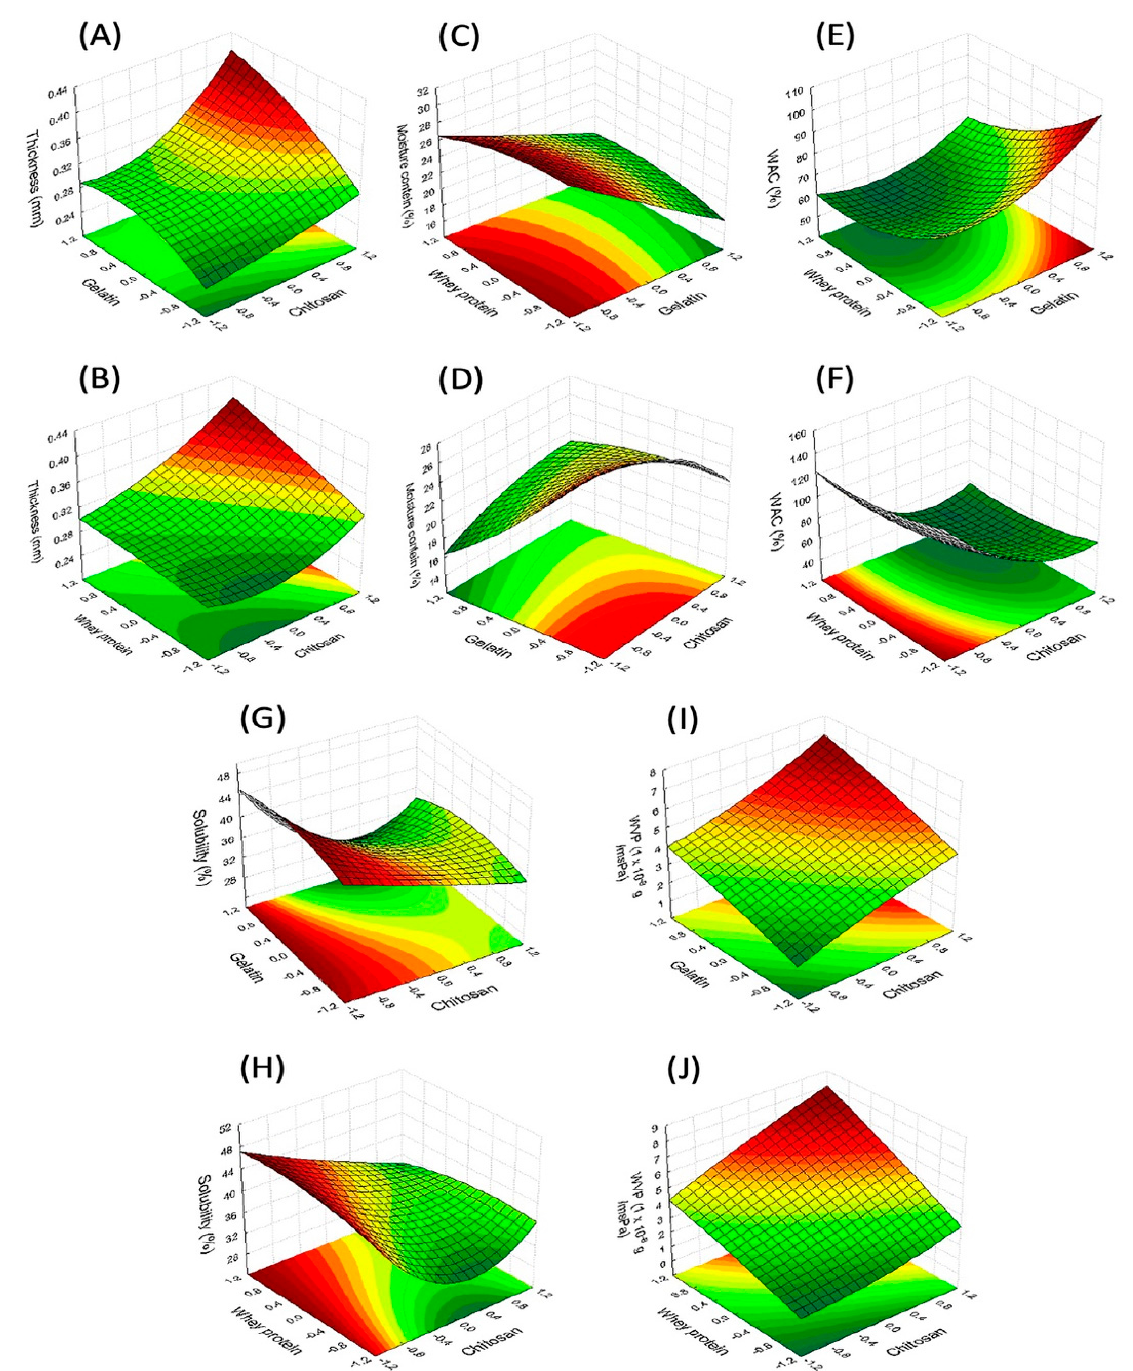
Figure 2. Response surface plots showing the interaction effects of process variables on T: thick- ness ( A , B ), MC: moisture content ( C , D ), WAC: water absorption capacity ( E , F ), S: solubility ( G , H ) and WVP: water vapor permeability ( I , J ). − 1.0 minimum level of component; 1.0, maximum level of component; 0, mid-level of component. For each surface plot, the level of the third factor is held at its central value. The regions with the dark red color represent the dominant working conditions, ensuring the maximum values for the variables